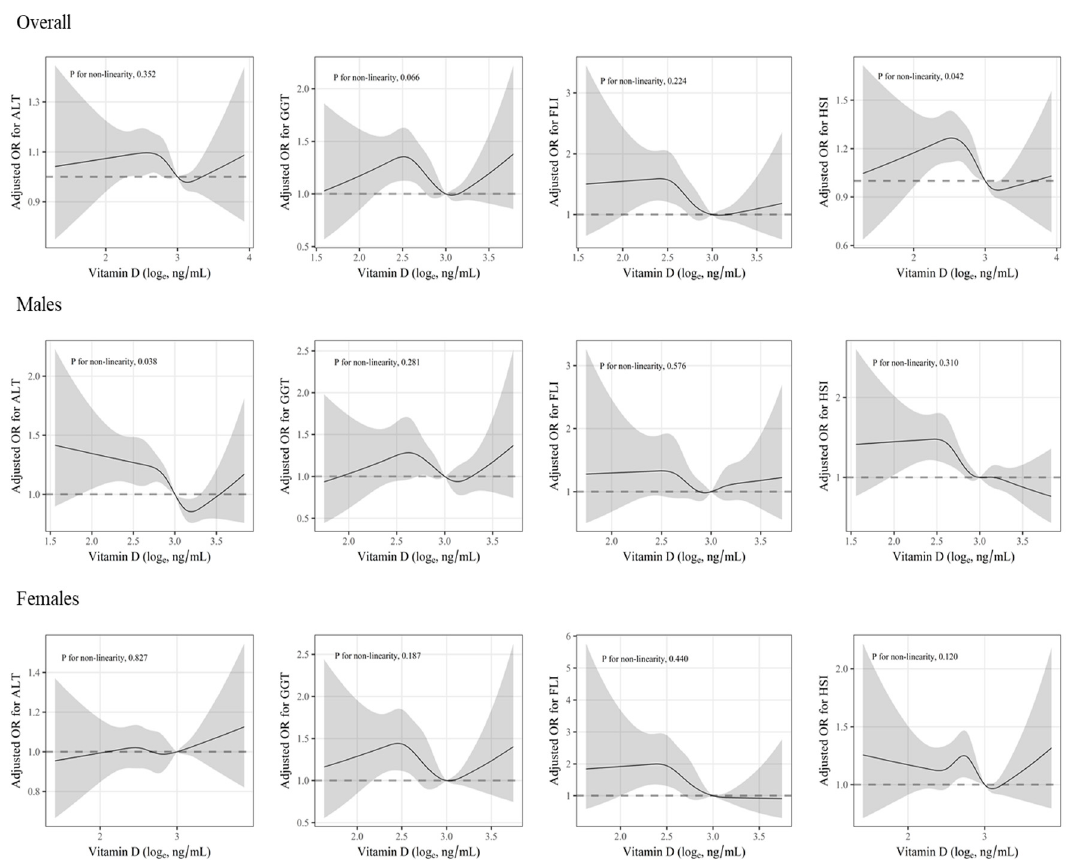
Figure 2. Nonlinear association between serum 25(OH)D levels and risk of suspected NAFLD. A restricted cubic smoothing spline model was applied to allow nonlinear associations. A serum 25(OH)D level of 20 ng/mL was set as the reference. The shaded parts indicate 95% CIs. ORs were adjusted for age, sex, alcohol consumption status (nondrinkers, moderate drinkers), smoking status (never smokers, former smokers, current smokers), level of family income, education level, BMI (continuous, in case of ALT and GGT), physical activity, and survey year.